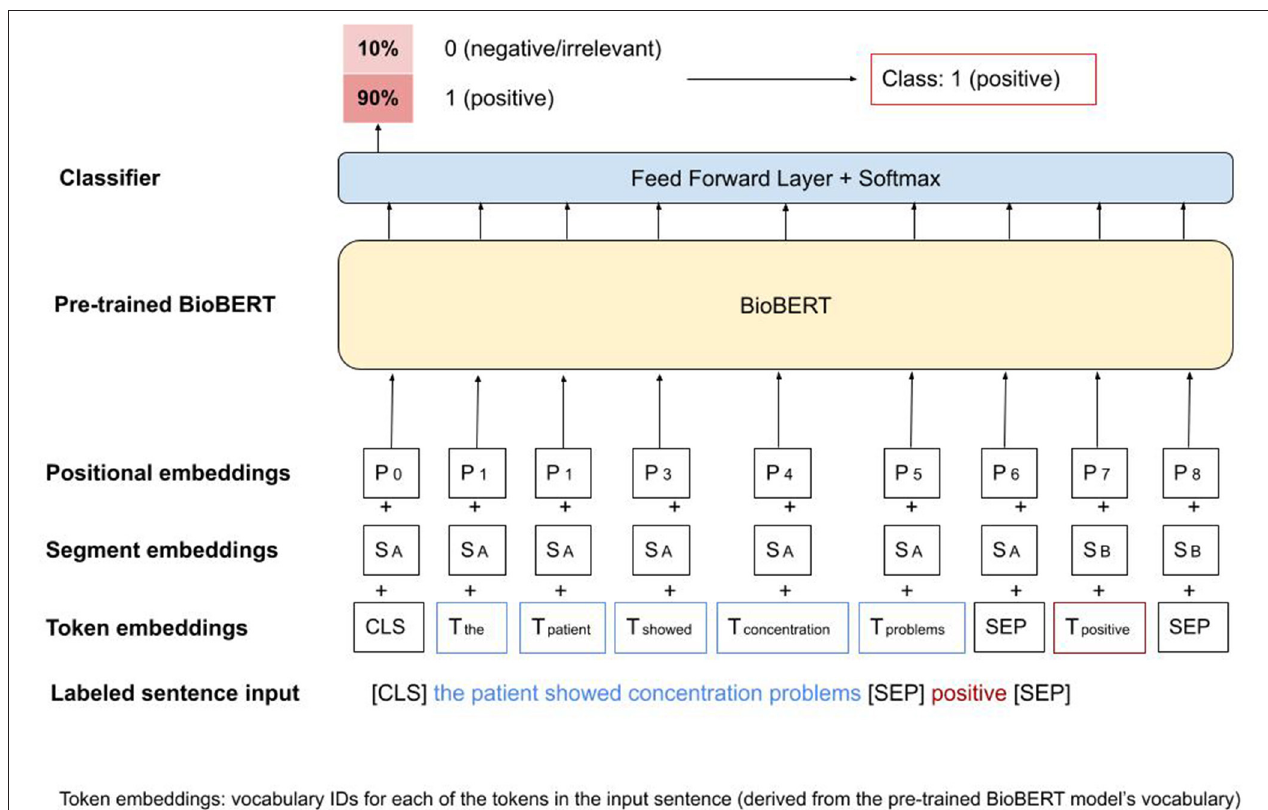
FIGURE 1 | BioBERT